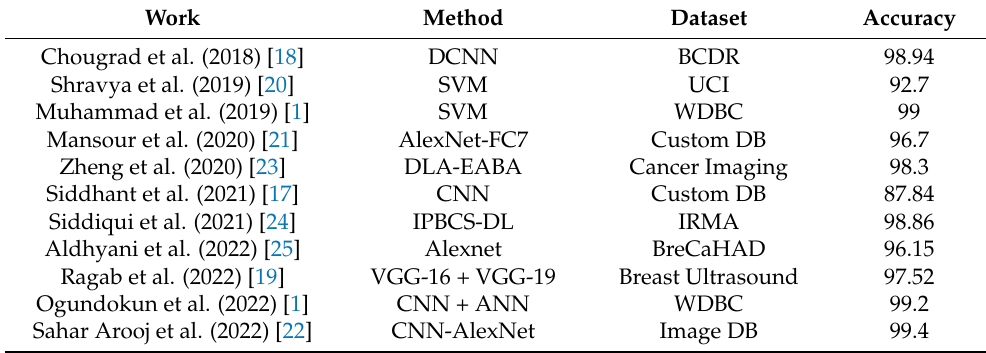
Table 1. Comparative analysis of existing